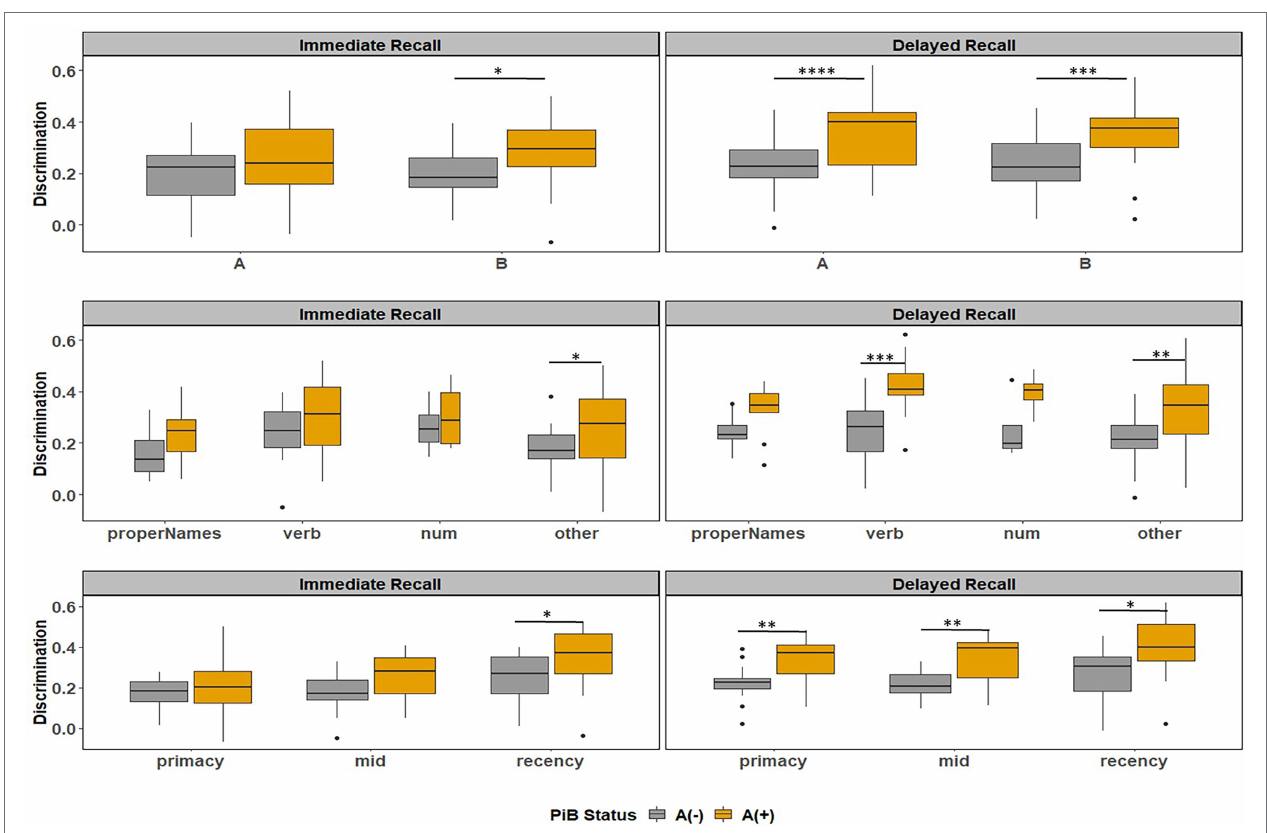
FIGURE 9 | Item discrimination plots by amyloid status according to the story (A and B), serial position (primacy, mid, and recency) as well as the lexical category of the items, by immediate recall and delayed recall. *< 0.05, **< 0.01, ***<0.001, and ****<0.0001.